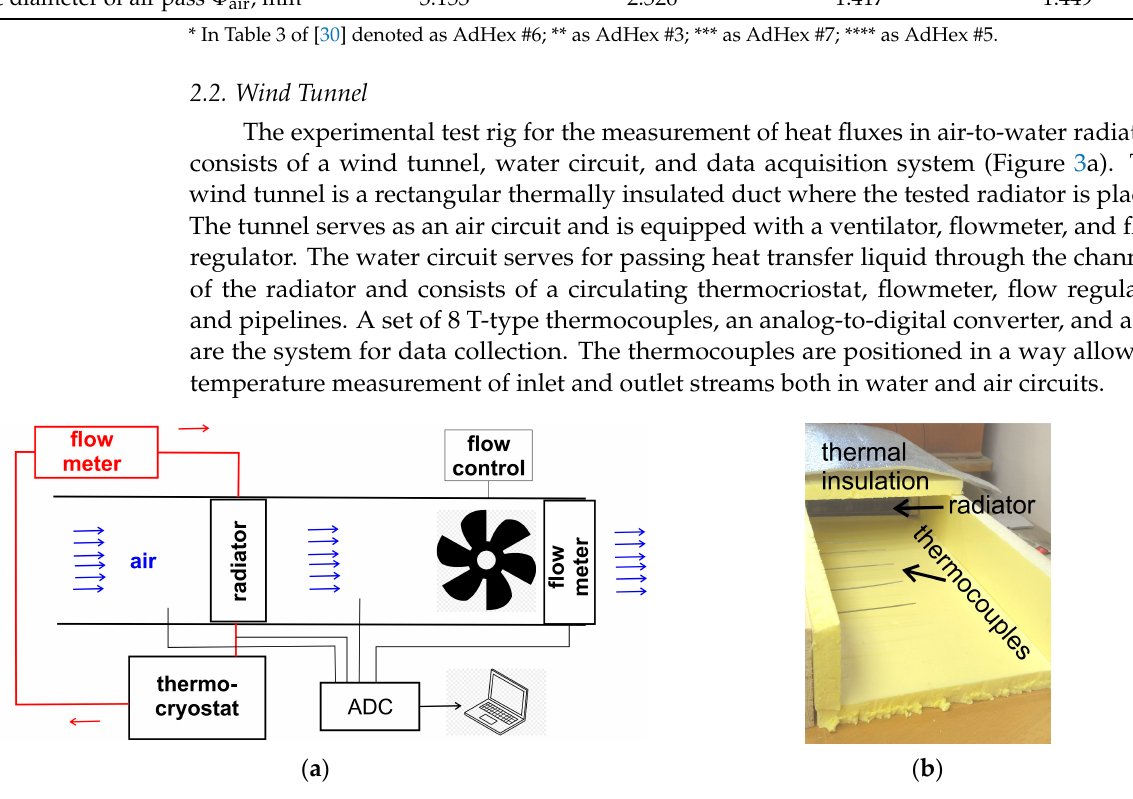
Figure 3. ( a ) Scheme of the test rig; ( b ) View of the outlet part of wind